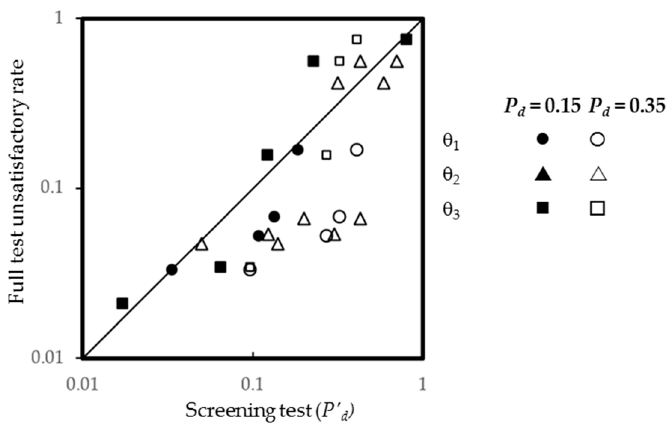
Figure 3. Full test unsatisfactory rate versus post-test failure probability.